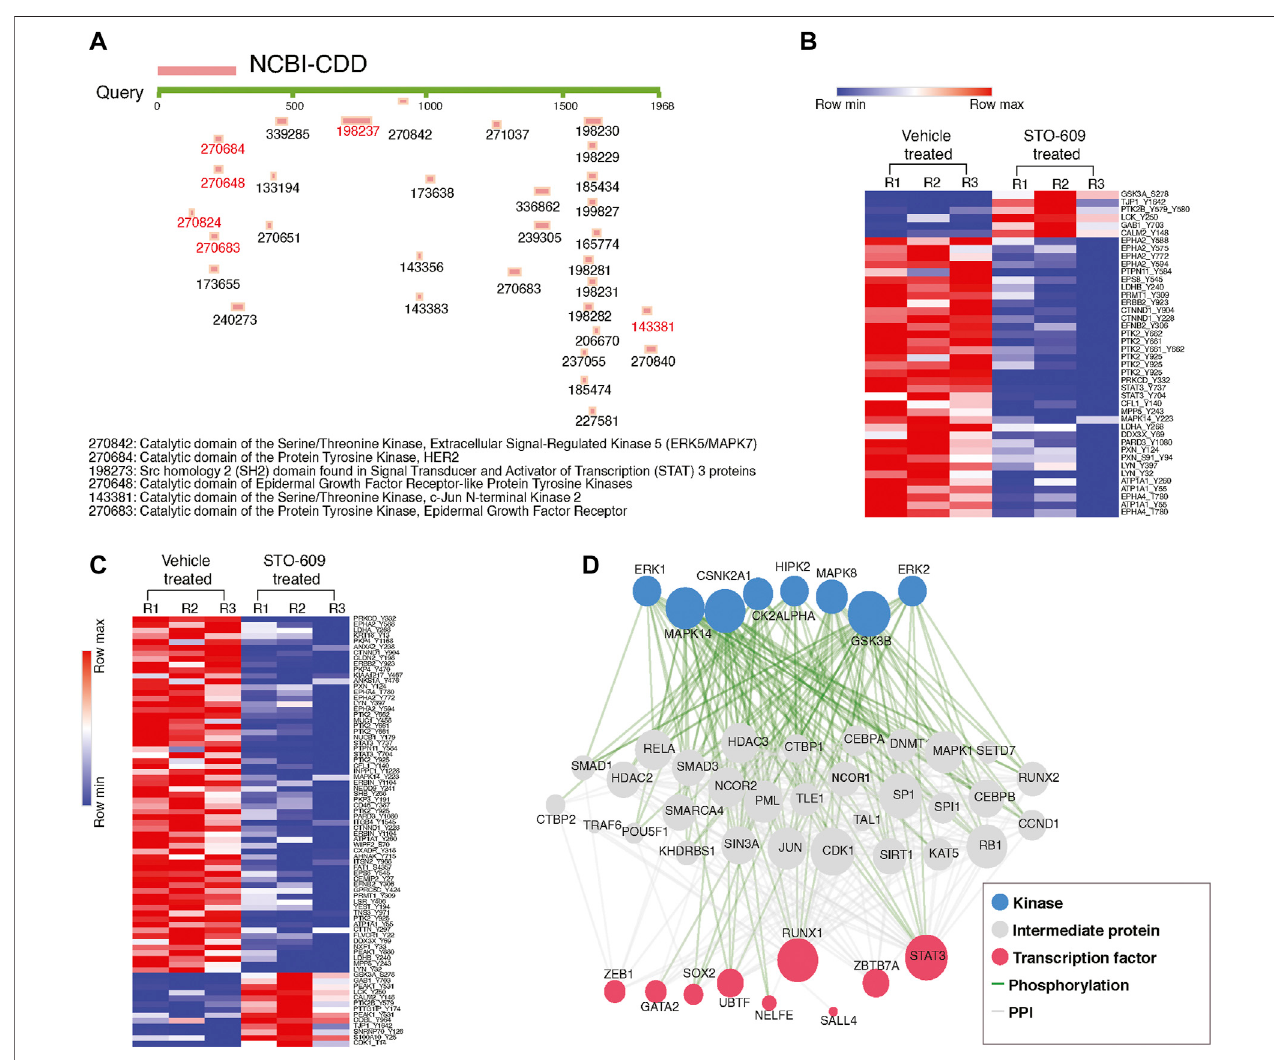
FIGURE 4 | Inhibition of CAMKK2 decreases the phosphorylation of tyrosine kinases in gastric cancer cells. (A) Domain analysis of hypophosphorylated peptides using MotifFinder tool against Conserved Domains Database (CDD). (B) Heat map showing the signi fi cantly altered phospho-Y-peptides of different kinases in gastric cancer cells (AGS) upon CAMKK2 inhibition. (C) Heat map showing the signi fi cantly altered phospho-Y-peptides ofdifferent non-kinases proteins in gastric cancer cells (AGS) upon CAMKK2 inhibition. (D) eXpression2Kinases analysis of hypo-Y-phosphorylated proteins on CAMKK2 in gastric cancer. Network shows kinases, protein – protein interaction, and transcriptional factors enriched in hypo-Y-phosphorylated data set in gastric cancer cells treated with